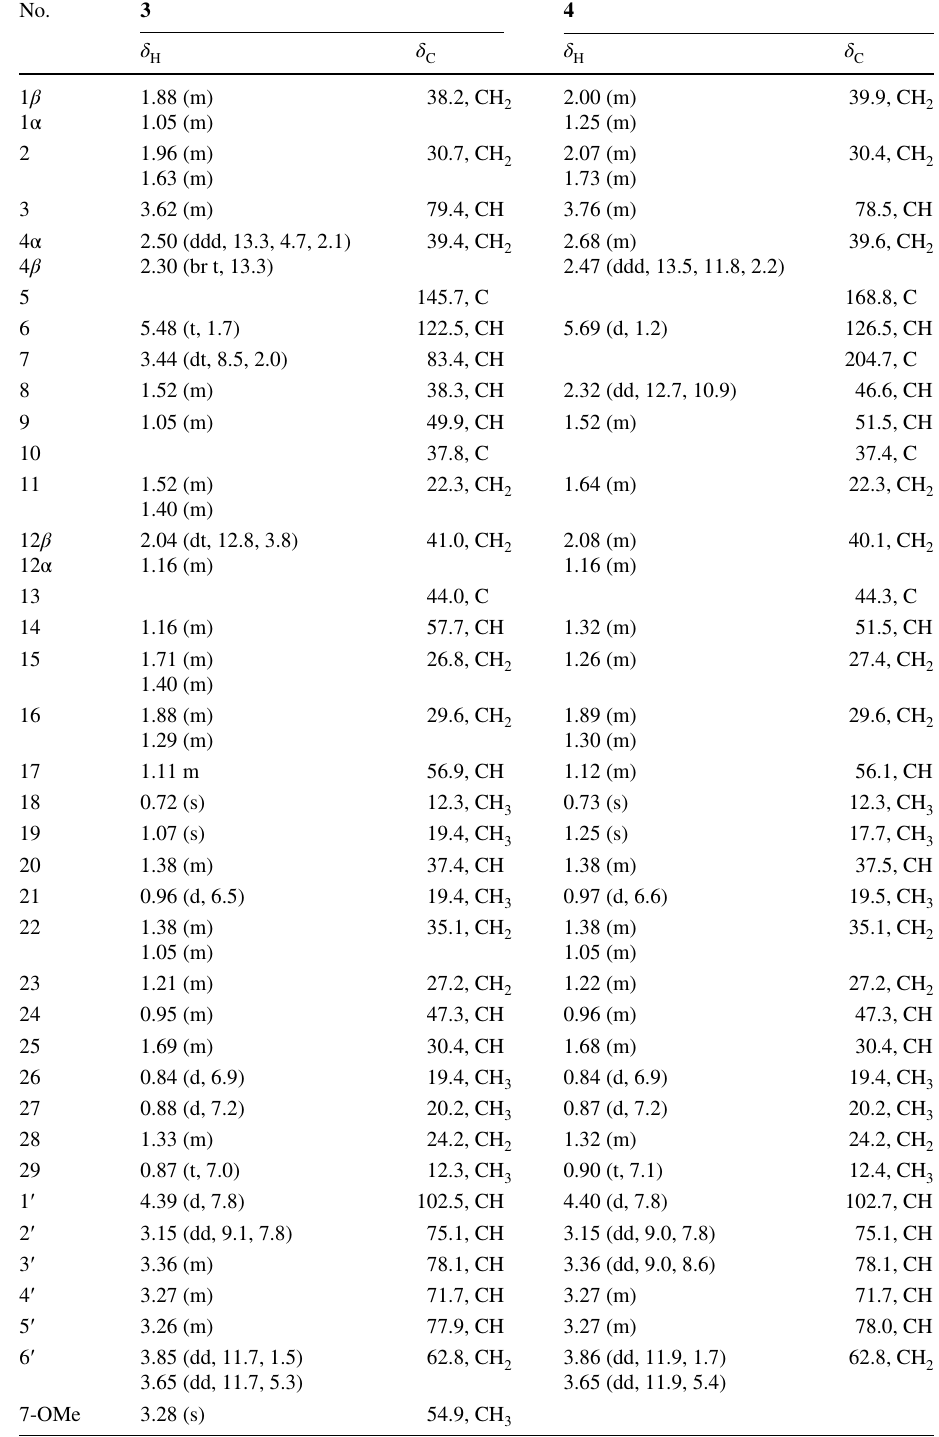
Table 2 1 H (800 MHz) and 13 C (200 MHz) NMR data of 3